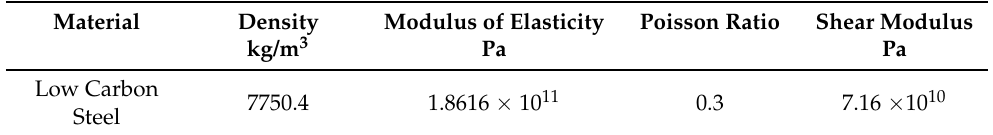
Table 1. Mechanical properties of